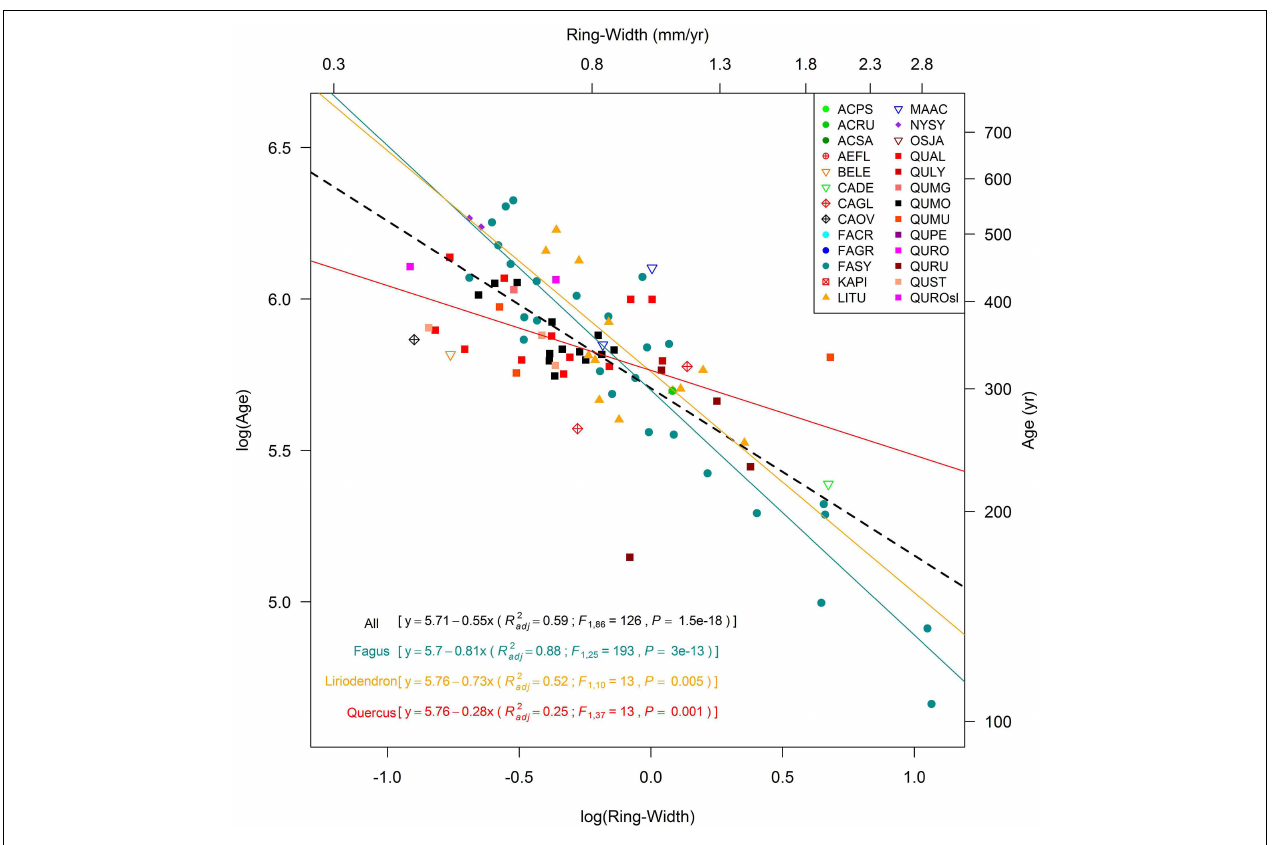
FIGURE 3 | Relationships between the age of the oldest deciduous tree within each temperate old-growth forest and its mean ring-width. Values are represented using log-transformed scales, regression lines were developed for all sites together and separately for the main genera (within